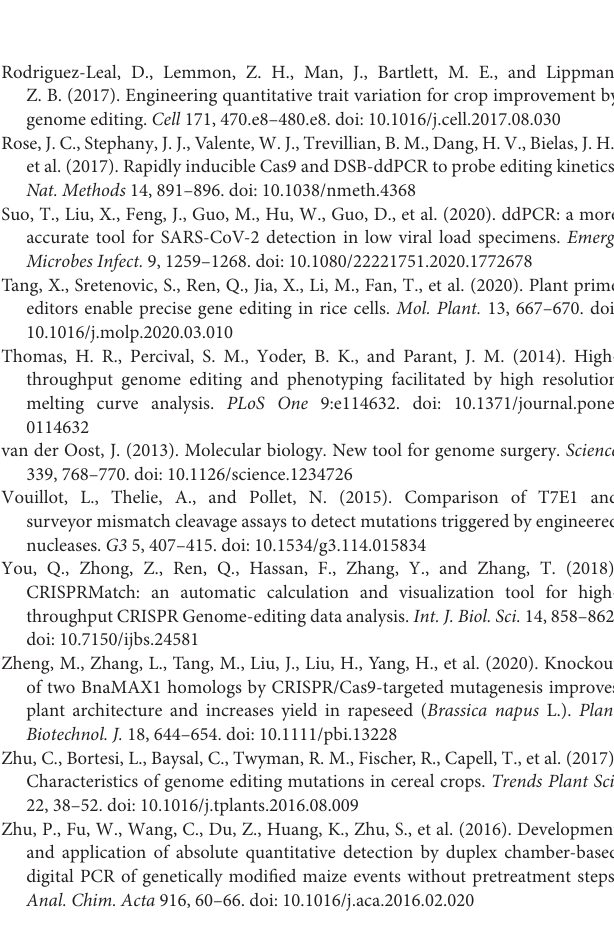
Supplementary Figure 1 | The droplet plots of the samples containing different initial concentrations of DNA. Supplementary Figure 2 | The droplet plots of DNA samples with the different gene-editing frequencies. Supplementary Table 1 | The source of gene-edited plants used in this